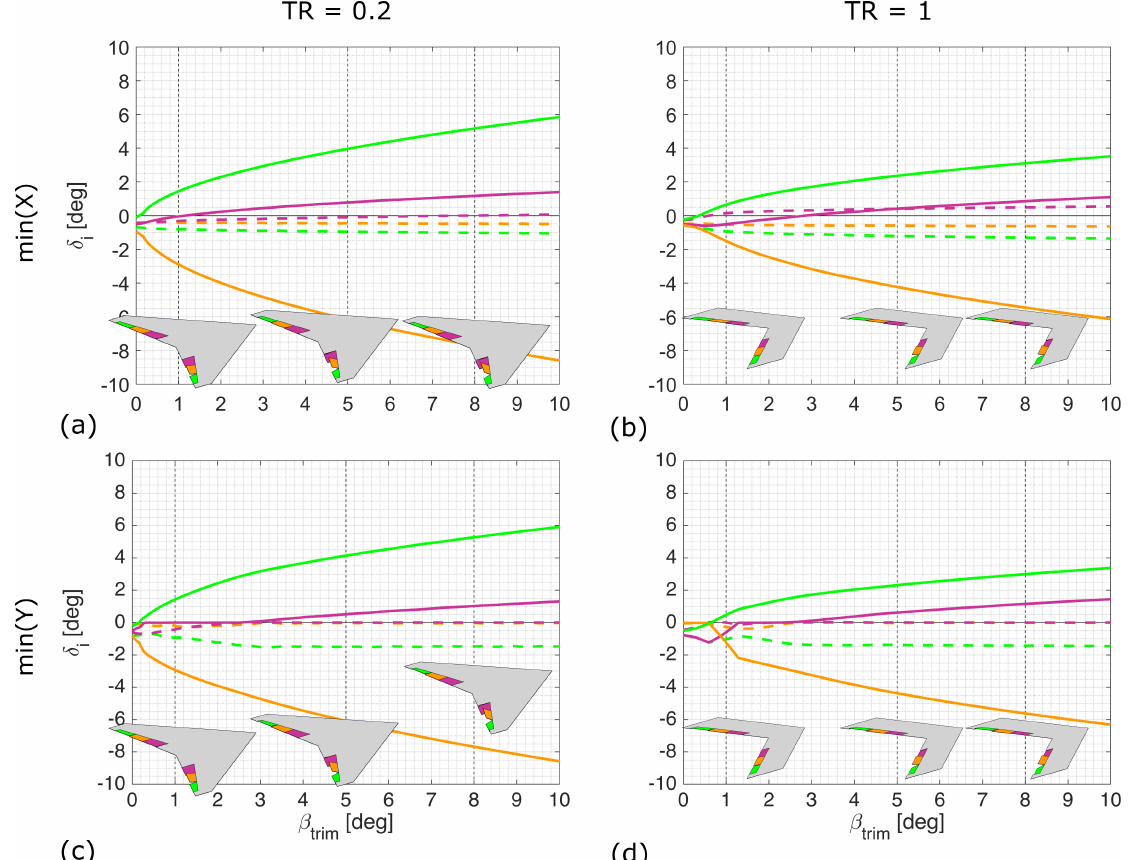
Figure 12. Deflection required to generate yawing moment to trim at sideslip for a 45 degree swept wing for objectives of maximising effectiveness ( a , b ) and minimising aggregate control deflection ( c , d ) with taper ratios 0.2 ( a , c ) and 1 ( b , d ). Dotted lines indicate port surfaces and solid lines are starboard surfaces, positive deflections trailing edge down. Inset shows deflections required to trim at one, five and eight degrees of